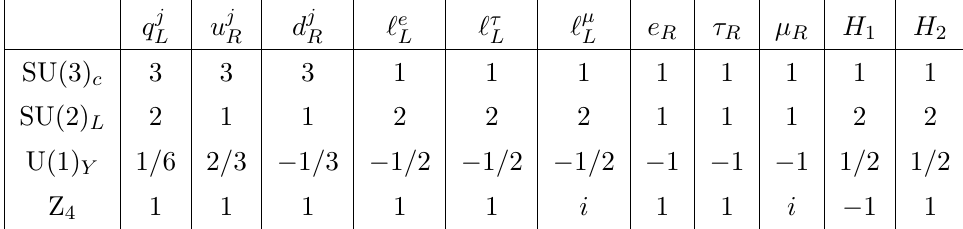
Table 1 . Particle contents and the charge